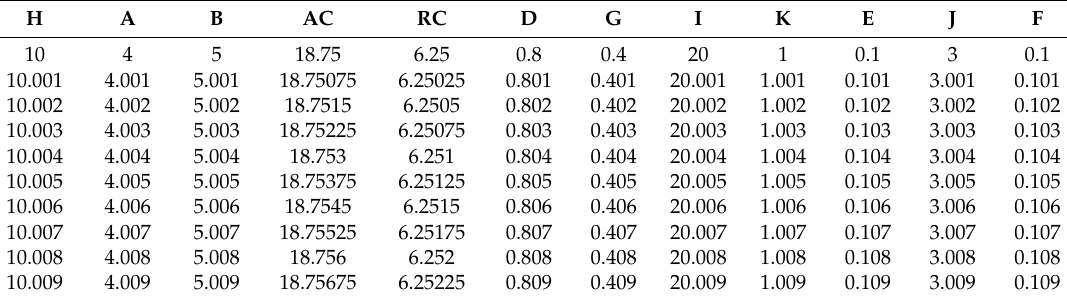
Table 3. Raw material ranges (in percentage/100